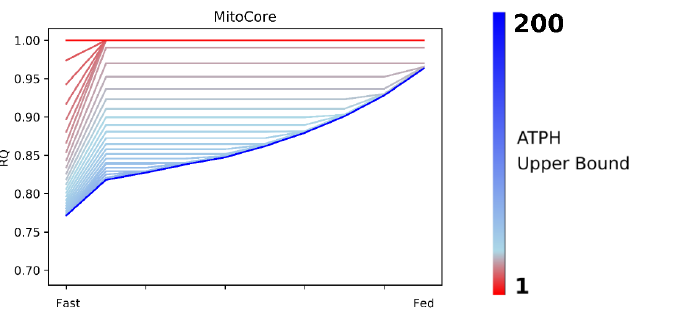
The constraints on this reaction were removed, yielding the predictions presented in Figure 2. Recon3D model gave inconsistent predictions with higher RQ values than ex- pected, for example, converging at RQ = 1.015: